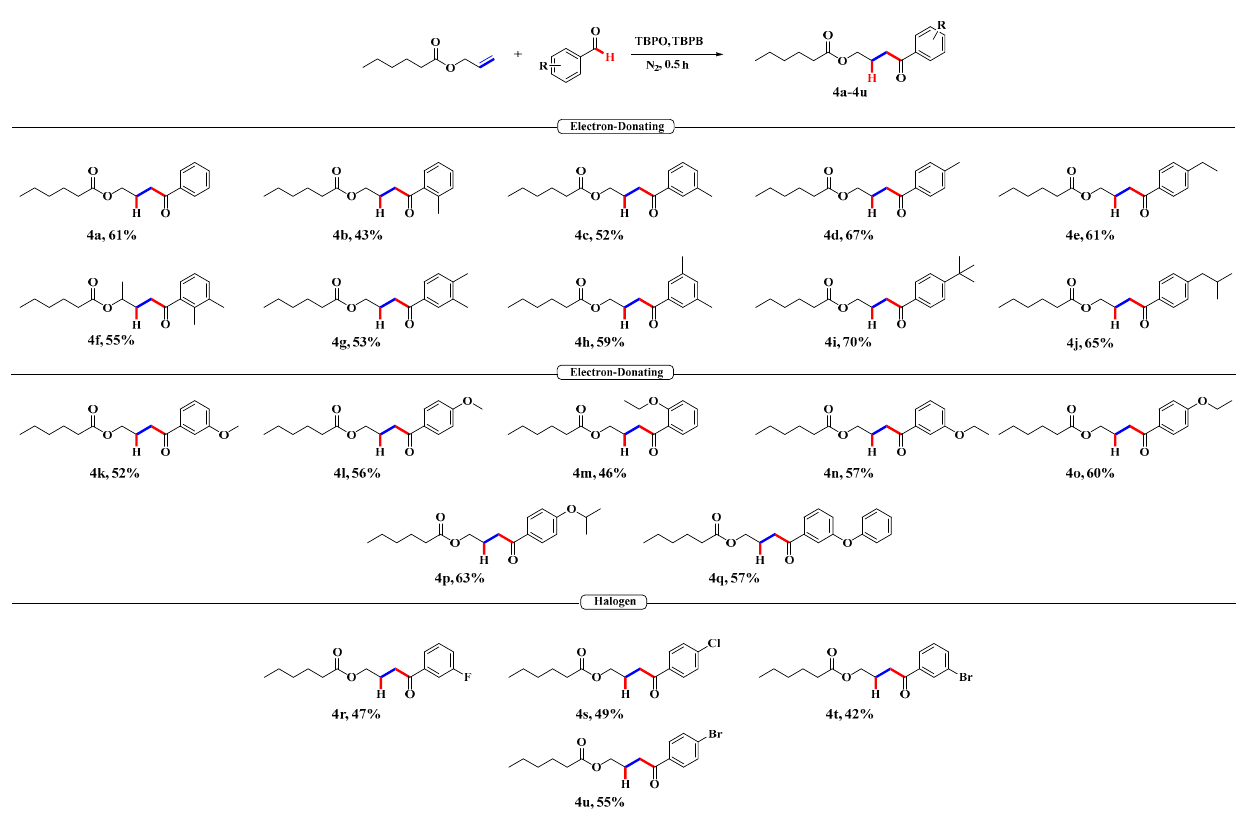
Figure 2. The radical additions of allyl hexanoate with substituted benzaldehyde.